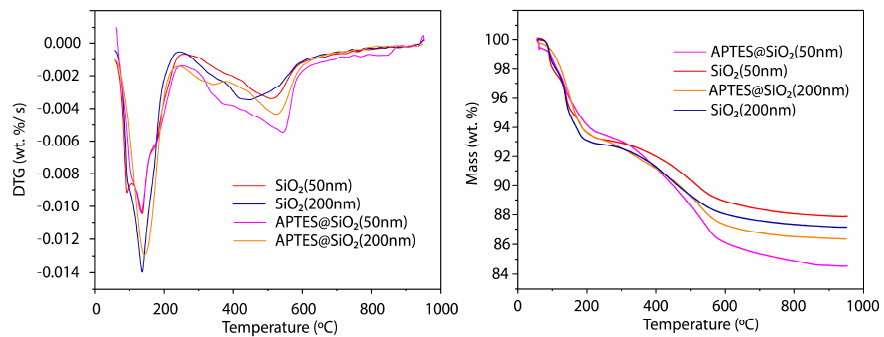
Figure 6. Thermal analysis ( left ) DTG and ( right ) TGA for SiO 2 (50/200 nm) and hybrids SiO 2 (50/200 nm)@APTES.